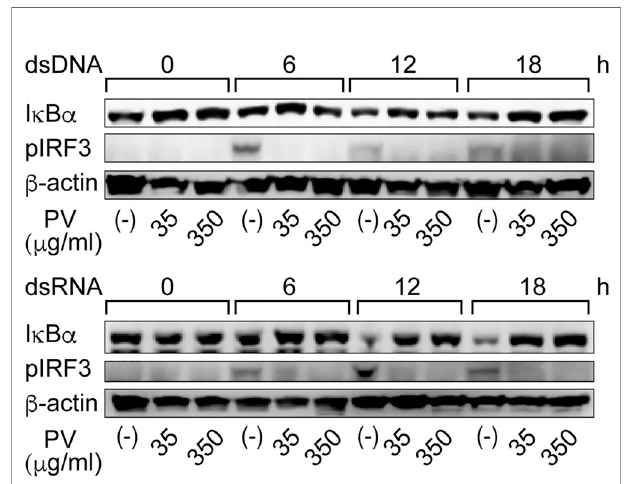
FIGURE 3 | PV suppresses degradation of I k B- a and phosphorylation of IRF3 induced by dsDNA or dsRNA. FRTL-5 cells were pretreated with PV at 35 m g/mL or 350 m g/mL for 24 h, then stimulated with 1 m g of dsDNA or dsRNA for the indicated period of time. Whole cell proteins were extracted, and Western blot analysis was performed to determine the protein expression levels of I k B- a , pIRF3 and b -actin.